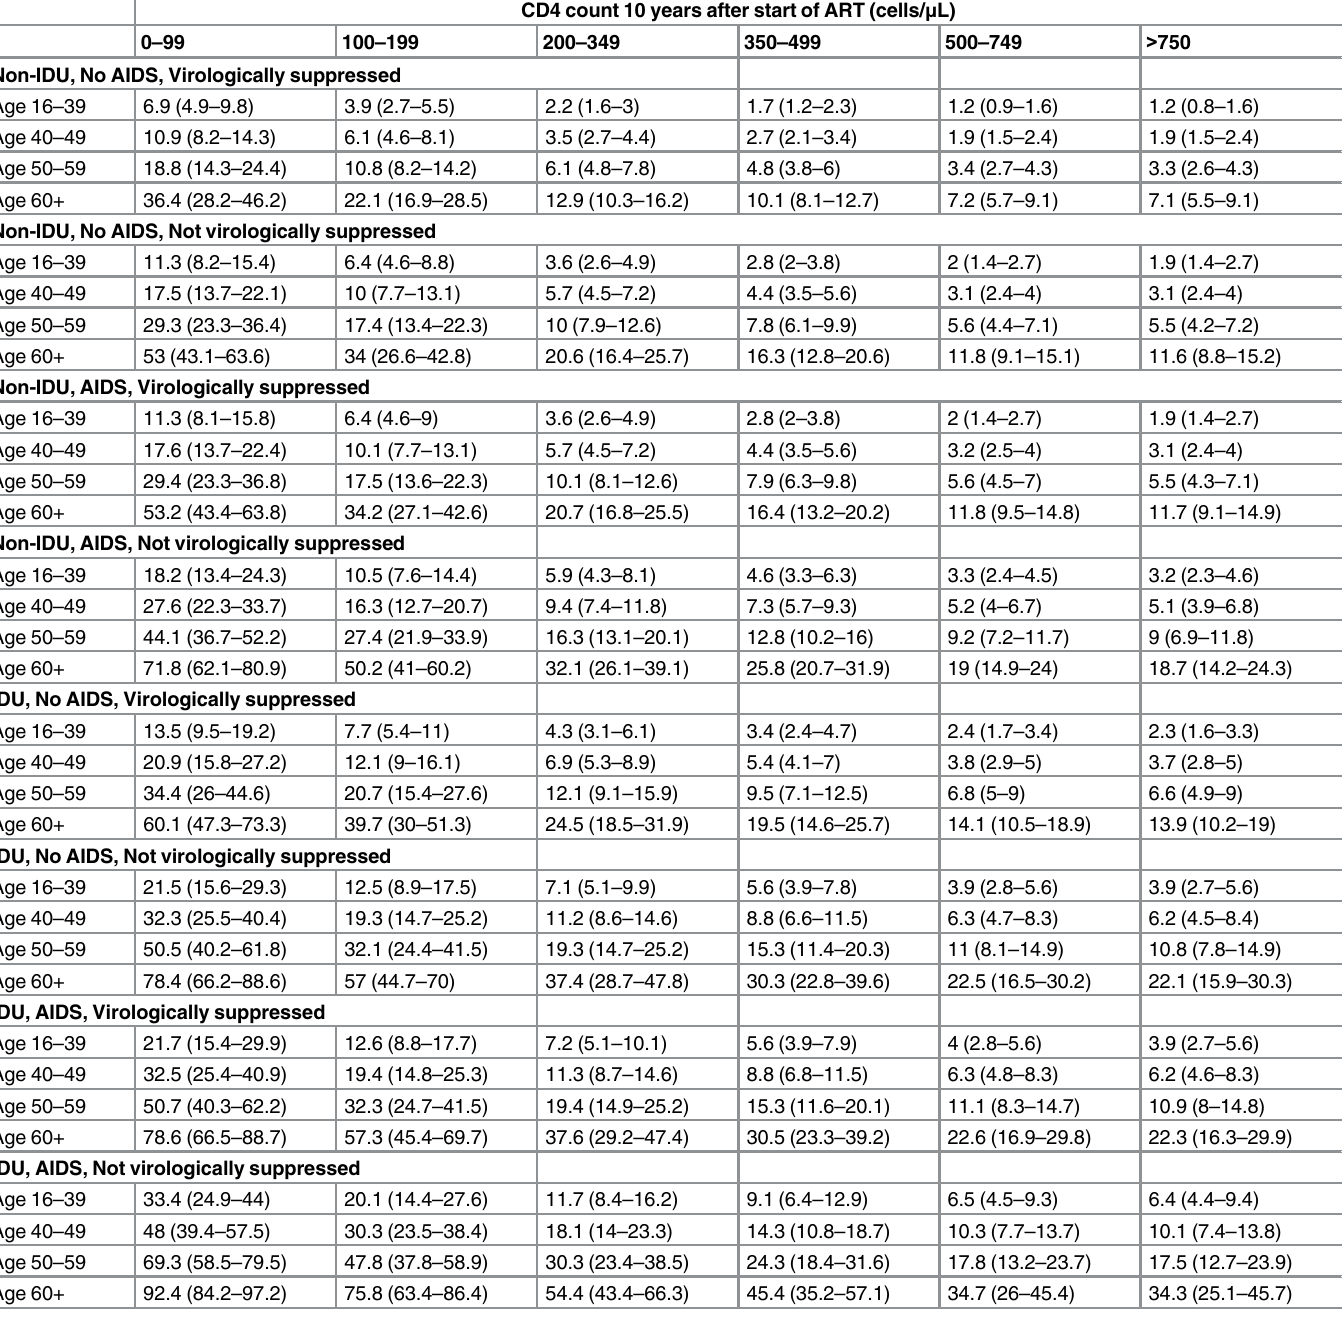
Table 5. 5-year percentage risk of death (95% CI) from 10 years after start of ART, according to age, IDU risk group, AIDS status, CD4 count and viral suppression (HIV RNA < 50 copies/mL) *